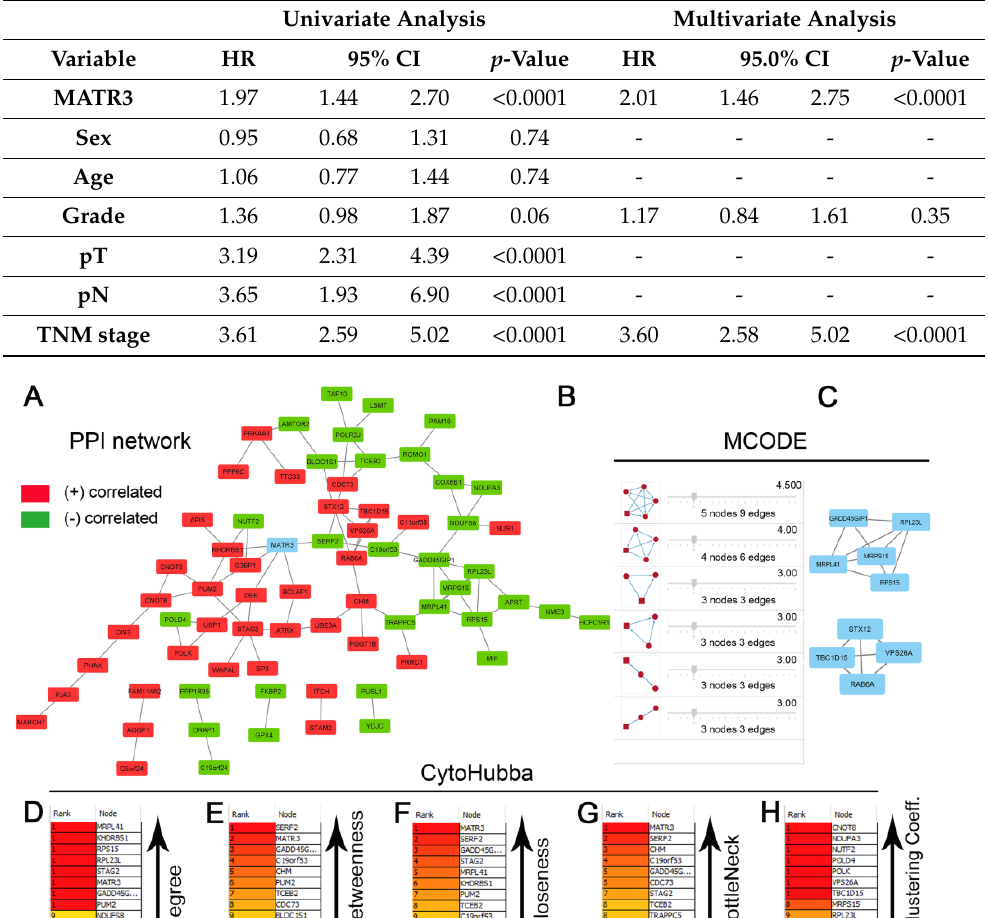
Table 4. Univariate and multivariate analyses of prognostic factors in the TCGA cohort by the Cox proportional hazard model. “-” indicates variable was not included in multivariate analysis. Univariate Analysis Multivariate Analysis